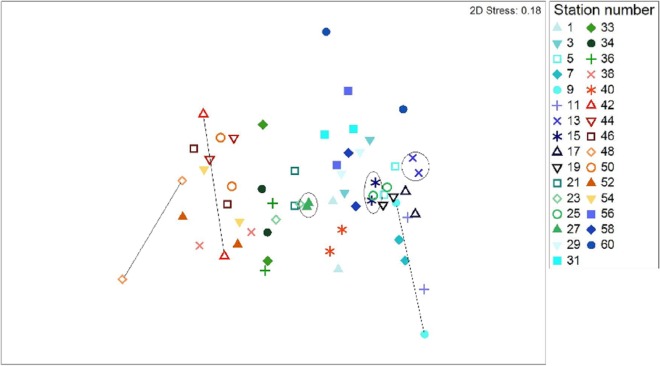
Two dimensional non-metric multidimensional scaling ordination (MDS) for 31 paired-by-method stations, based on square root-transformation density data and a Bray–Curtis similarity matrix.Numbers correspond to the stations presented in Fig. 1. Paired-by-method stations with the highest similarities between the two methods are indicated by a circle, while those stations with the lowest similarities are joined with a straight line. North Aegean region stations (1–31 and 56–60) are marked in blue–green colors, while South Aegean stations (33–54) are depicted by red–orange colors.